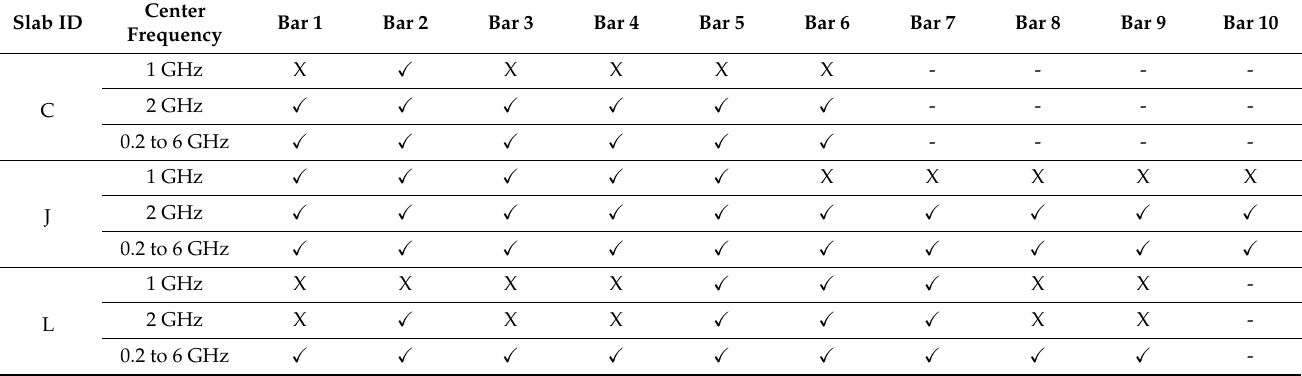
Table 7. Bar detectability in depth slices performed using devices with different center